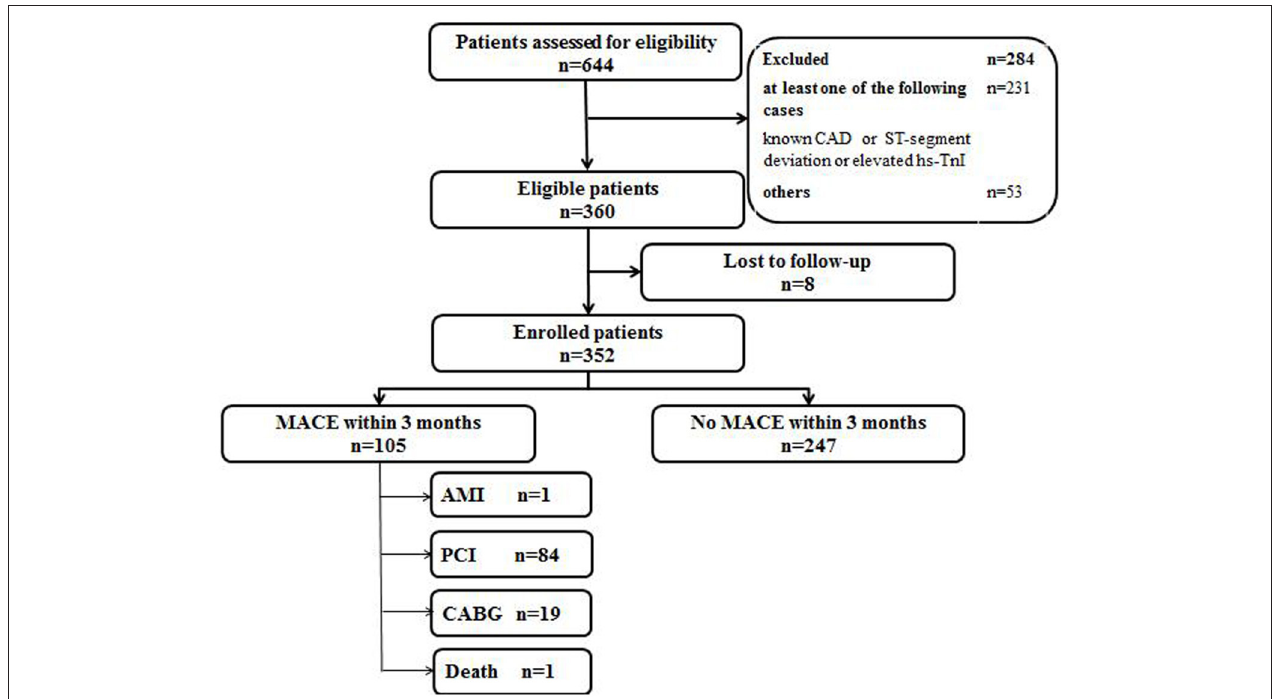
FIGURE 2 | Flow diagram of participants in the validation cohort study. CAD, coronary artery disease; hs-TnI, high-sensitivity Troponin I; MACE, major adverse coronary events; AMI, acute myocardial infarction; PCI, percutaneous coronary intervention; CABG, coronary artery bypass graft.